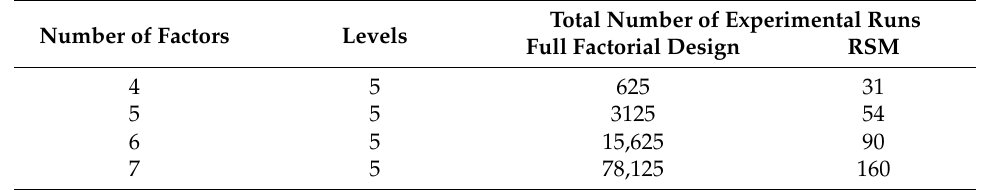
Table 1. Total number of experimental runs for full factorial design and RSM based on 5-level factors. Total Number of Experimental Runs Number of Factors Levels Full Factorial